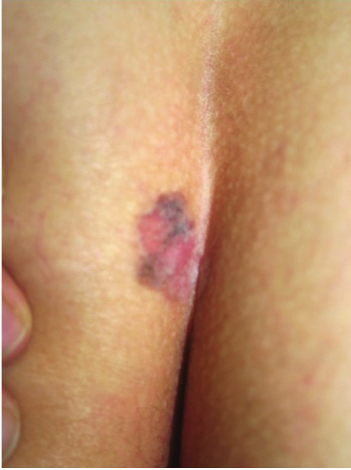
Figure 3: Case 2. Pigmented lesion on the left buttock and intergluteal fold.